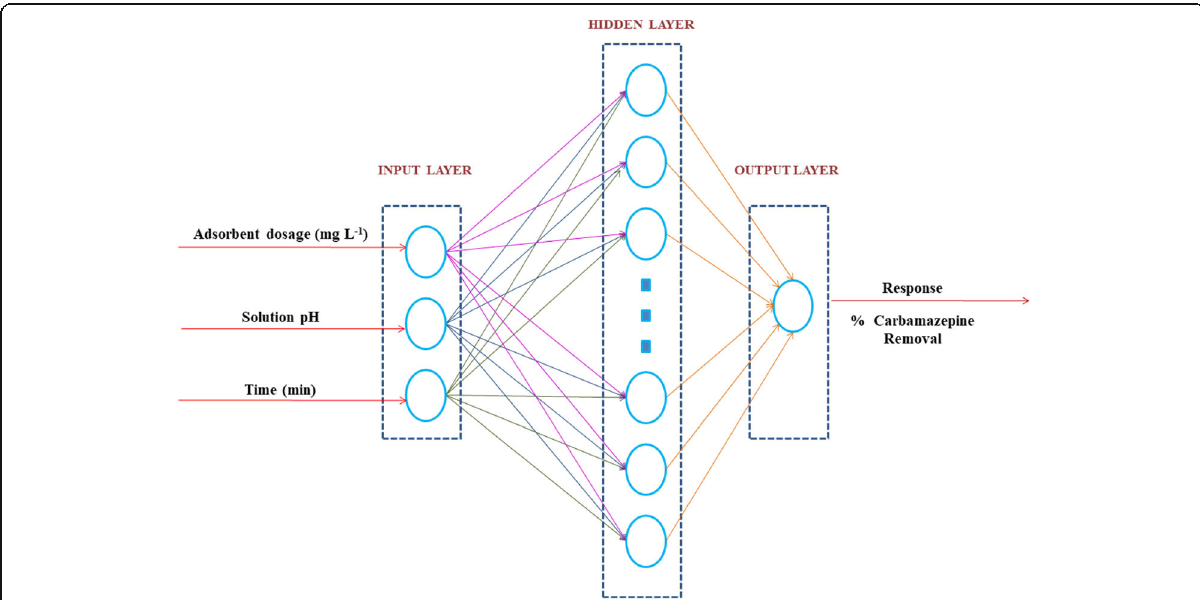
Fig. 1 Schematic architecture of developed back-propagation ANN model for optimization and modelling of Carbamazepine (CBZ) adsorption over graphene oxide